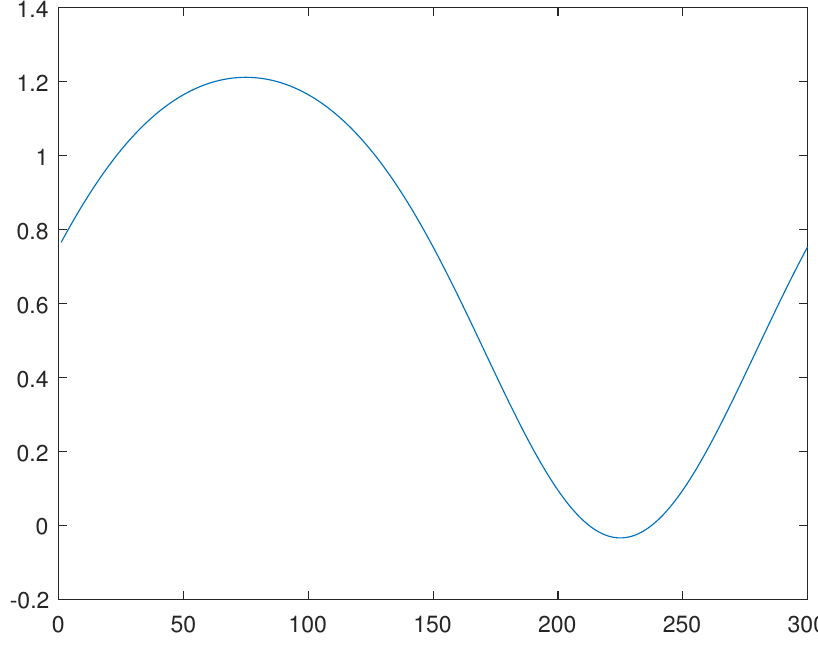
Figure 12. Line 8, solution u 8 ( x ) through the minimization of functional J